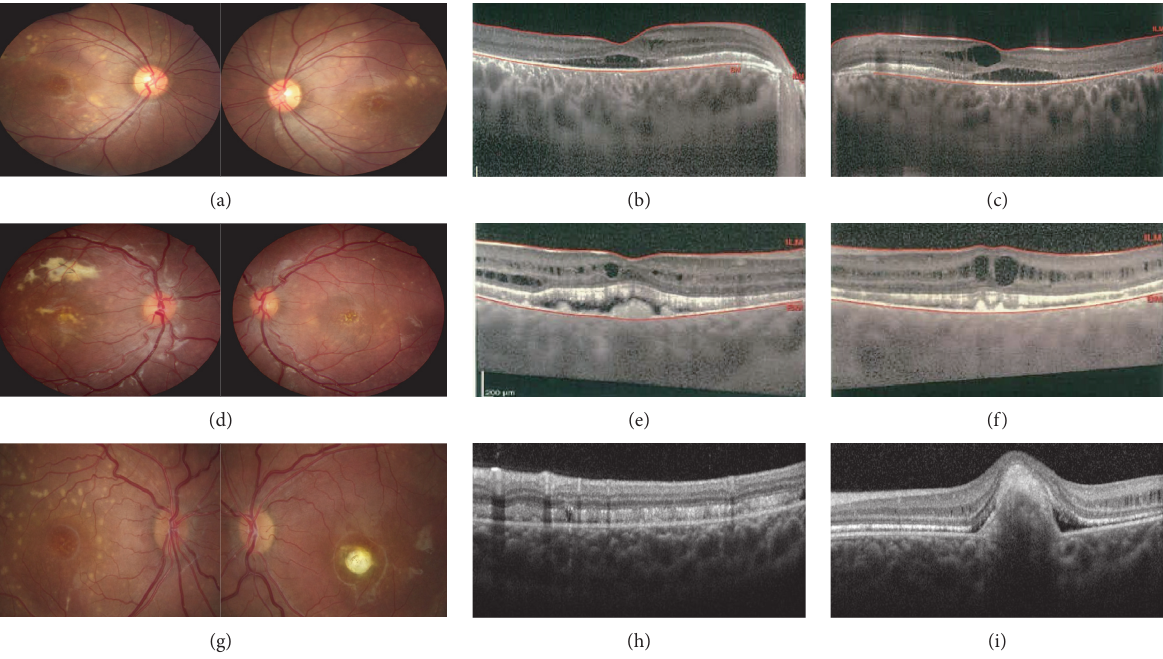
Figure 2: Fundus photo (a, d, g) and pachychoroid in enhanced depth imaging optical coherence tomography (EDI-OCT) (b, c, e, f, h, i) of three patients. Patient no. 8 (first line) was a 16-year-old female with significant pachychoroid in EDI-OCT (b, c) that was diagnosed with angle closure in both eyes in gonioscopy without glaucoma. Patient no. 6 (second line) is an 11-year-old female with high hyperopia that shows significant pachychoroid in EDI-OCT (e, f). She also was diagnosed with angle closure in both eyes in gonioscopy without glaucoma. Patient no. 4 (last line) also shows pachychoroid changes in EDI-OCT (g, i). She also shows a fibrotic pillar in left eye OCT